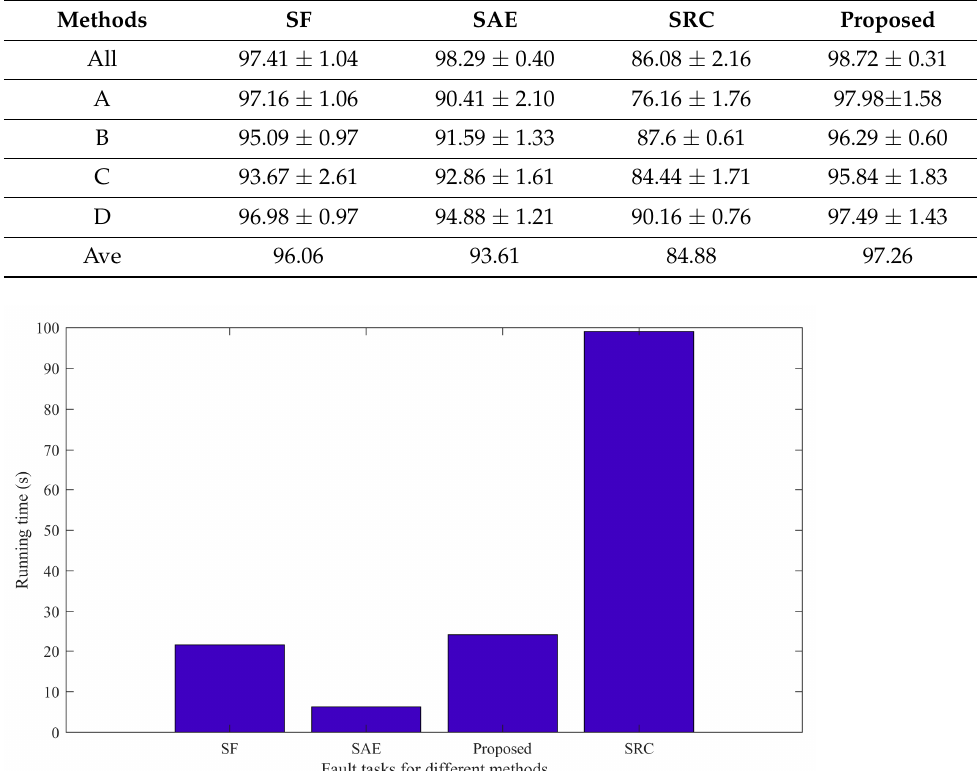
Figure 4. Bearing diagnosis results of the three methods under various working conditions.